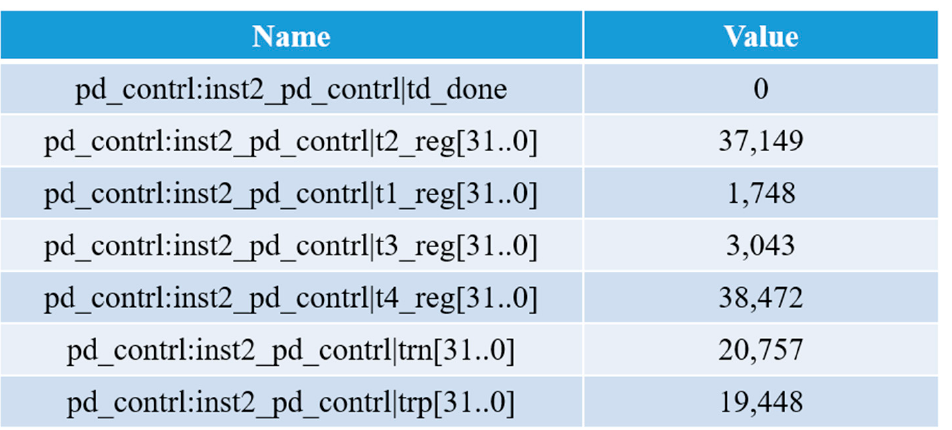
Figure 19. The signal captured by an FPGA logic analyzer.